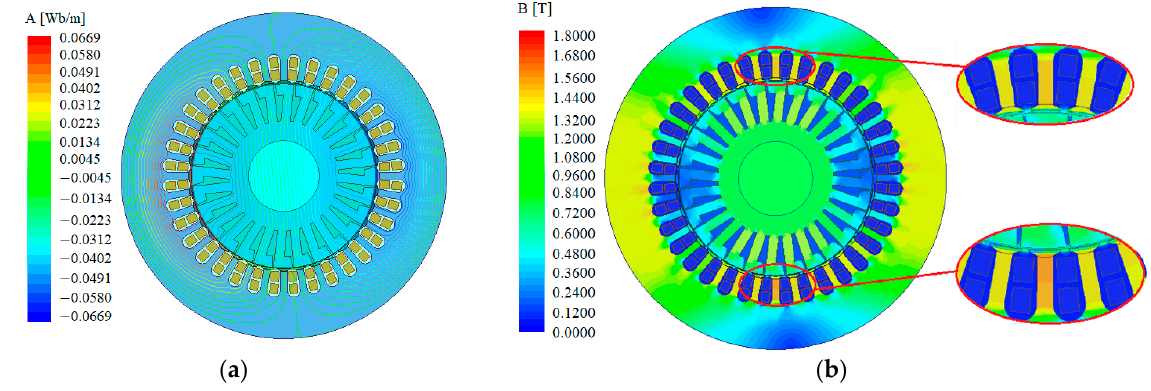
Figure 9. The magnetic lines distribution and magnetic density diagram of the motor under static eccentric conditions: ( a ) magnetic lines distribution; ( b ) magnetic density diagram.